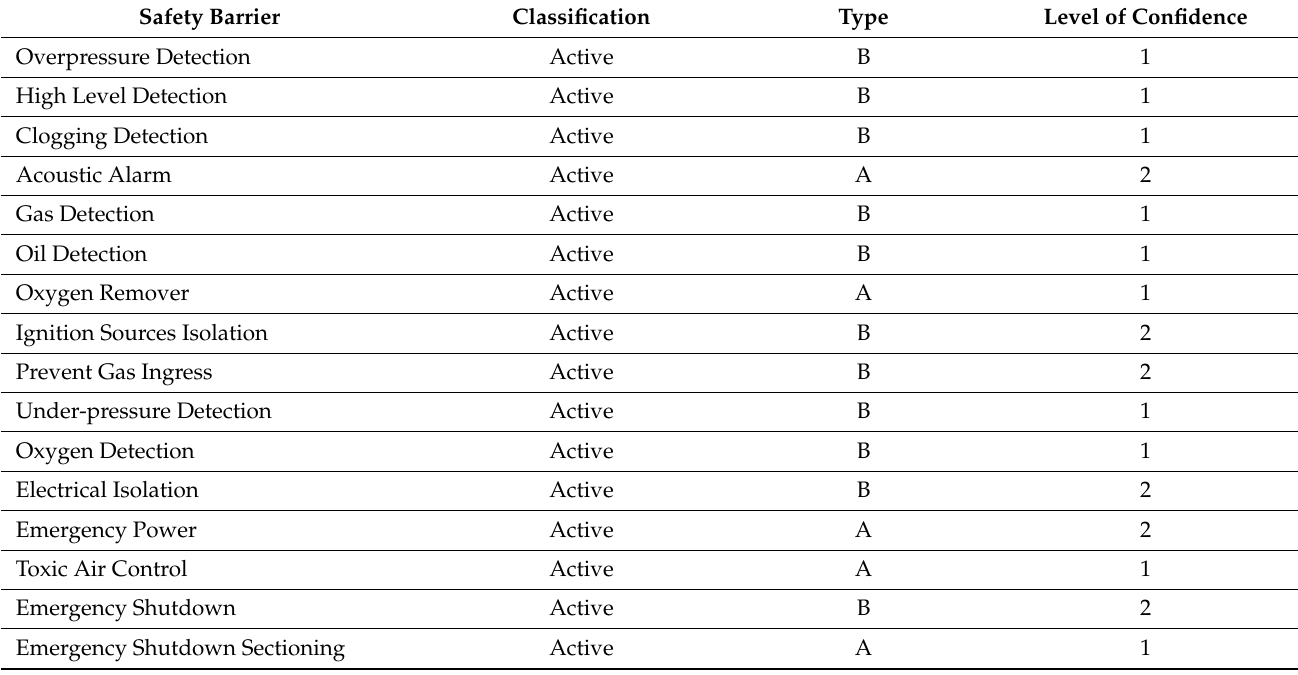
Table 4. Goliat Safety Barriers. Type A = the failure modes of all components are thoroughly defined, failure data from field experience exists, and the behavior under fault conditions can be determined. Type B = the failure modes are not thoroughly defined for each component, the behavior under fault conditions cannot be determined a priori, and failure data exist but not for all the components.